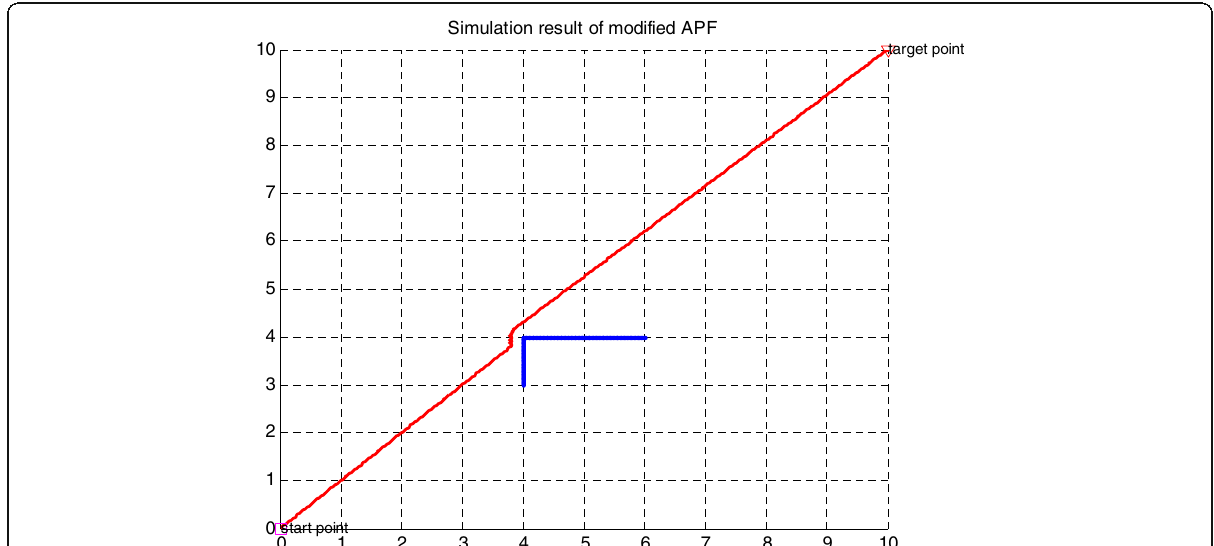
Fig. 26 The result of the broken line obstacle simulation in the modified artificial potential field